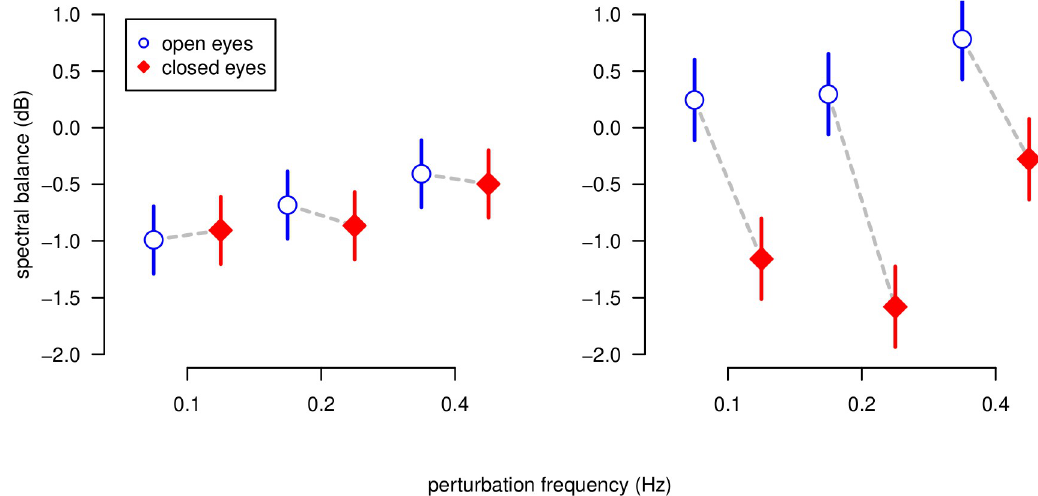
Fig 4. Spectral balance values predicted by the mixed-effects linear model. The values predicted for MSSQ = 0 (no susceptibility to motion sickness) are shown on the left panel and ones predicted for MSSQ = 14 (high susceptibility to motion sickness) on the right panel. EO cases are shown as open squares and EC as solid